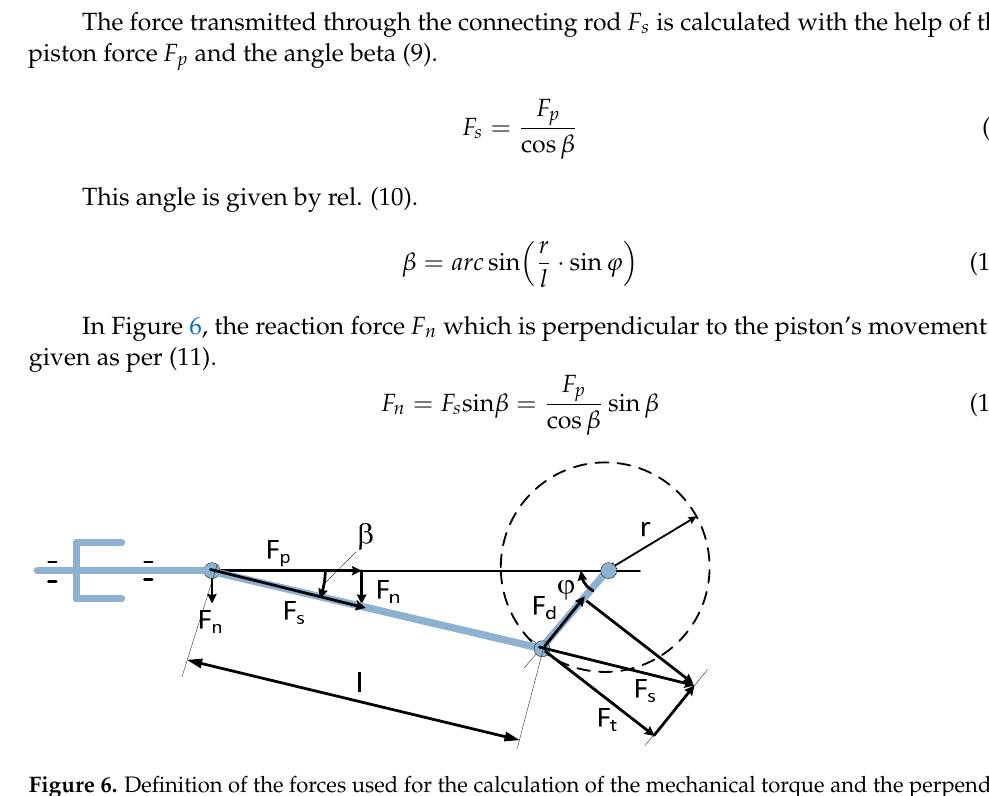
Figure 6. Definition of the forces used for the calculation of the mechanical torque and the perpendicular reaction.